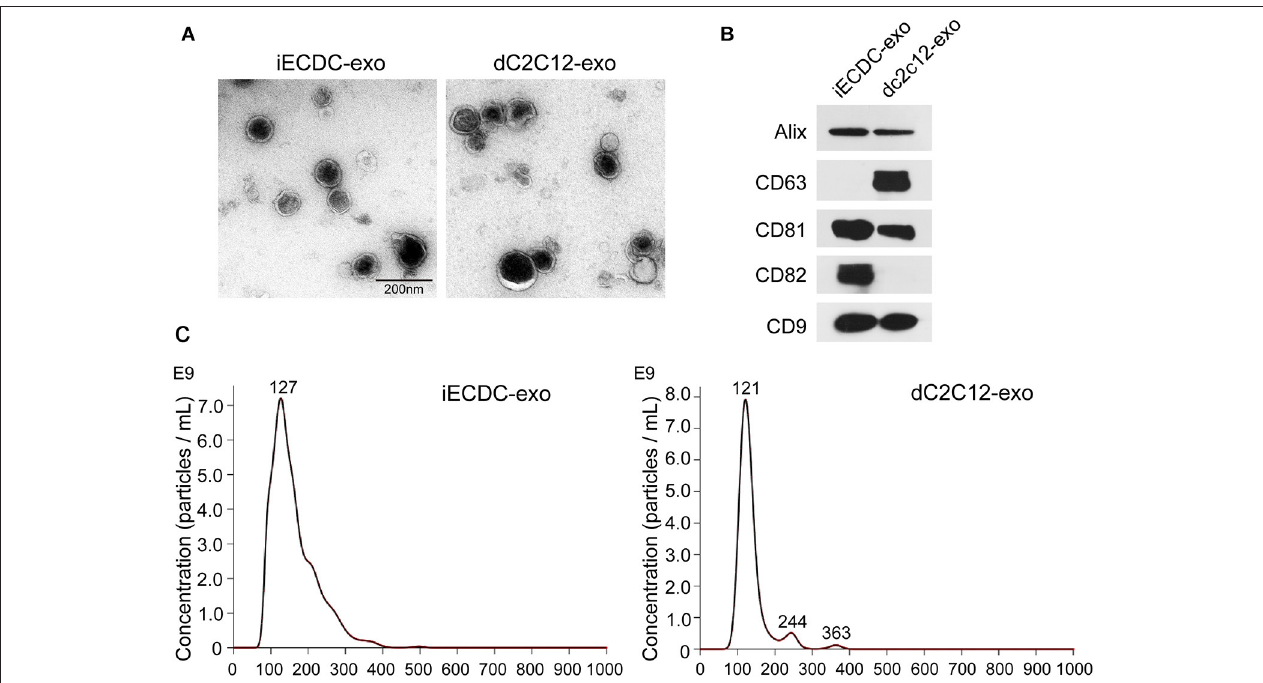
FIGURE 7 | Characterization of iECDC exosomes. (A) Transmission electron microscope images of isolated dC2C12 and iECDC exosomes (scale bar = 200nm). (B) Western blots to detect membrane proteins on dC2C12 and iECDC exosomes. Total protein (30 µ g) was loaded and anti-Alix, CD63, CD81, CD82, and CD9 antibodies were used. (C) Measurement of exosome size distribution with Nanoparticle Tracking Analysis (NTA) (Nanosight, Westborough, MA,